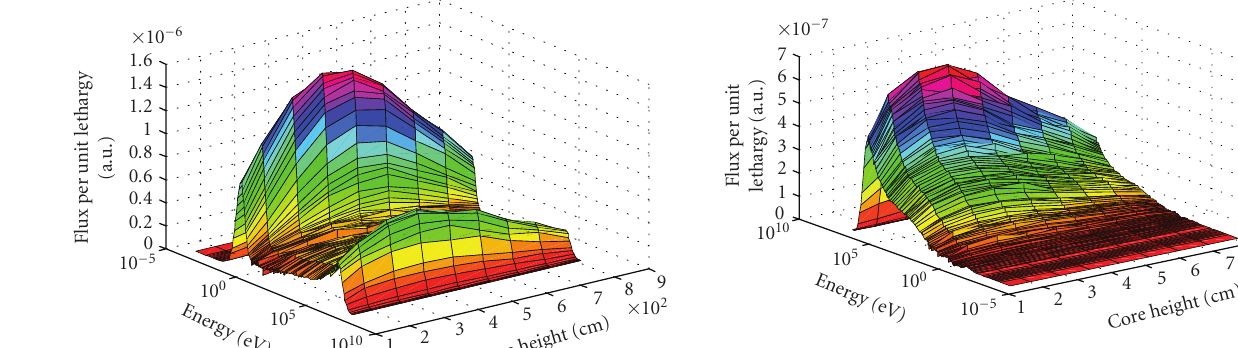
Figure 5: 3D space-energy neutron distribution in the TRU-fueled VHTR (neutron fluxes in compacts of the innermost fuel ring as a function of their axial locations in the TRU-fueled core (55.86% fissile atom fraction, C/HM =